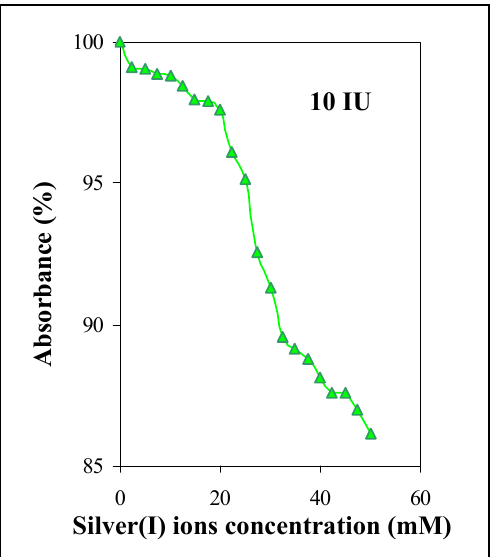
Figure 12. The changes of activity of commercially available urease in the presence of silver(I)